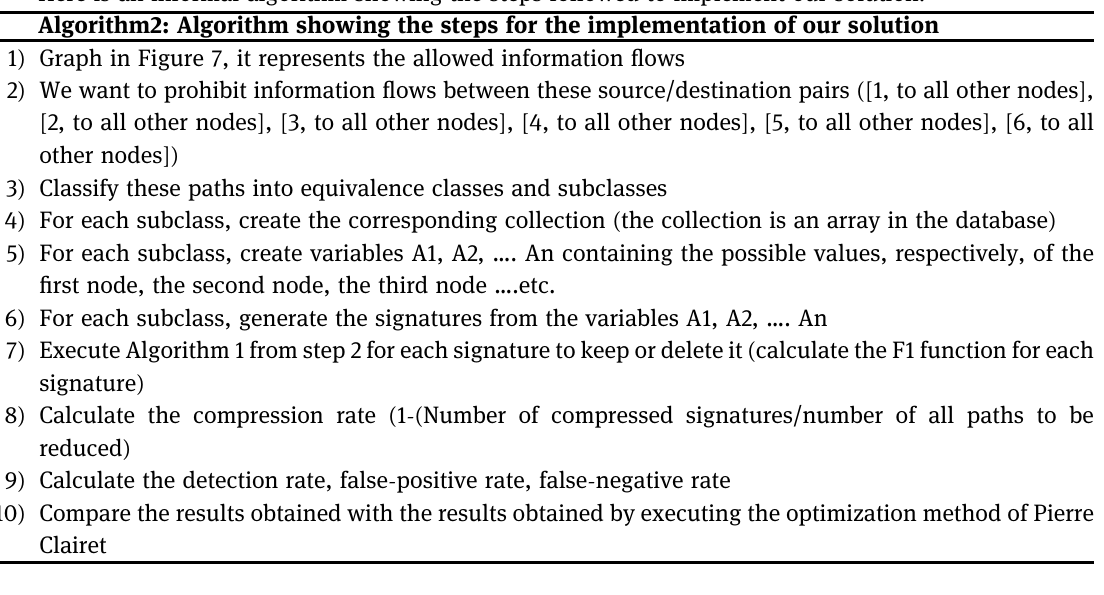
Algorithm2: Algorithm showing the steps for the implementation of our solution